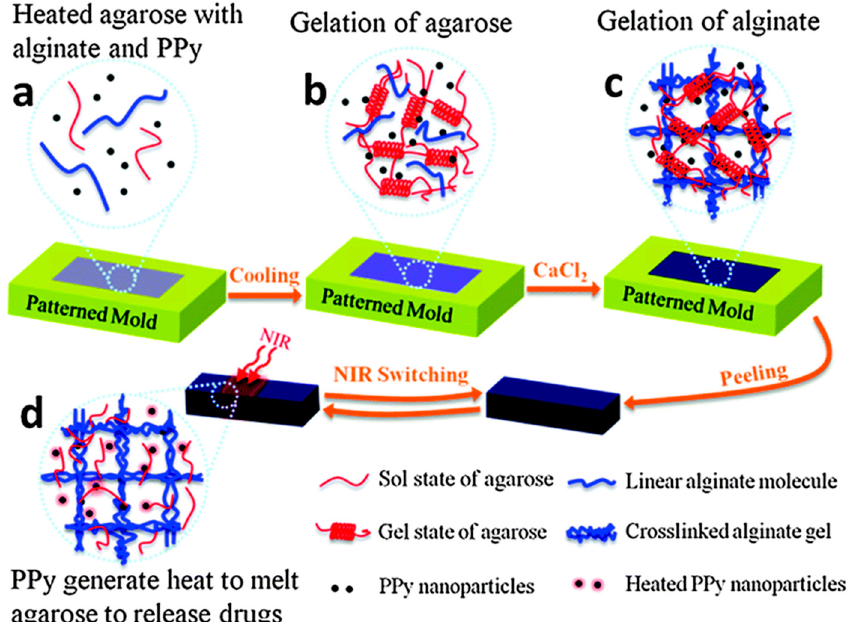
Figure 11. Schematic illustration of a NIR laser responsive deformation-free hydrogel containing embedded polypyrrole ( PPy) NPs: ( a ) pre-heated agarose solution was mixed with alginate and PPy NPs and injected into patterned mold; ( b ) cooling to induce gelation of agarose, determining shape of the hydrogel and served as a template for alginate gelation; ( c ) CaCl 2 was added to form an alginate network, which provided the mechanical support during laser irradiation; ( d ) periodic switching of NIR laser to digitally control agarose melting for pulsatile drug release, reproduced with permission from [408]. Copyright Royal Society of Chemistry,